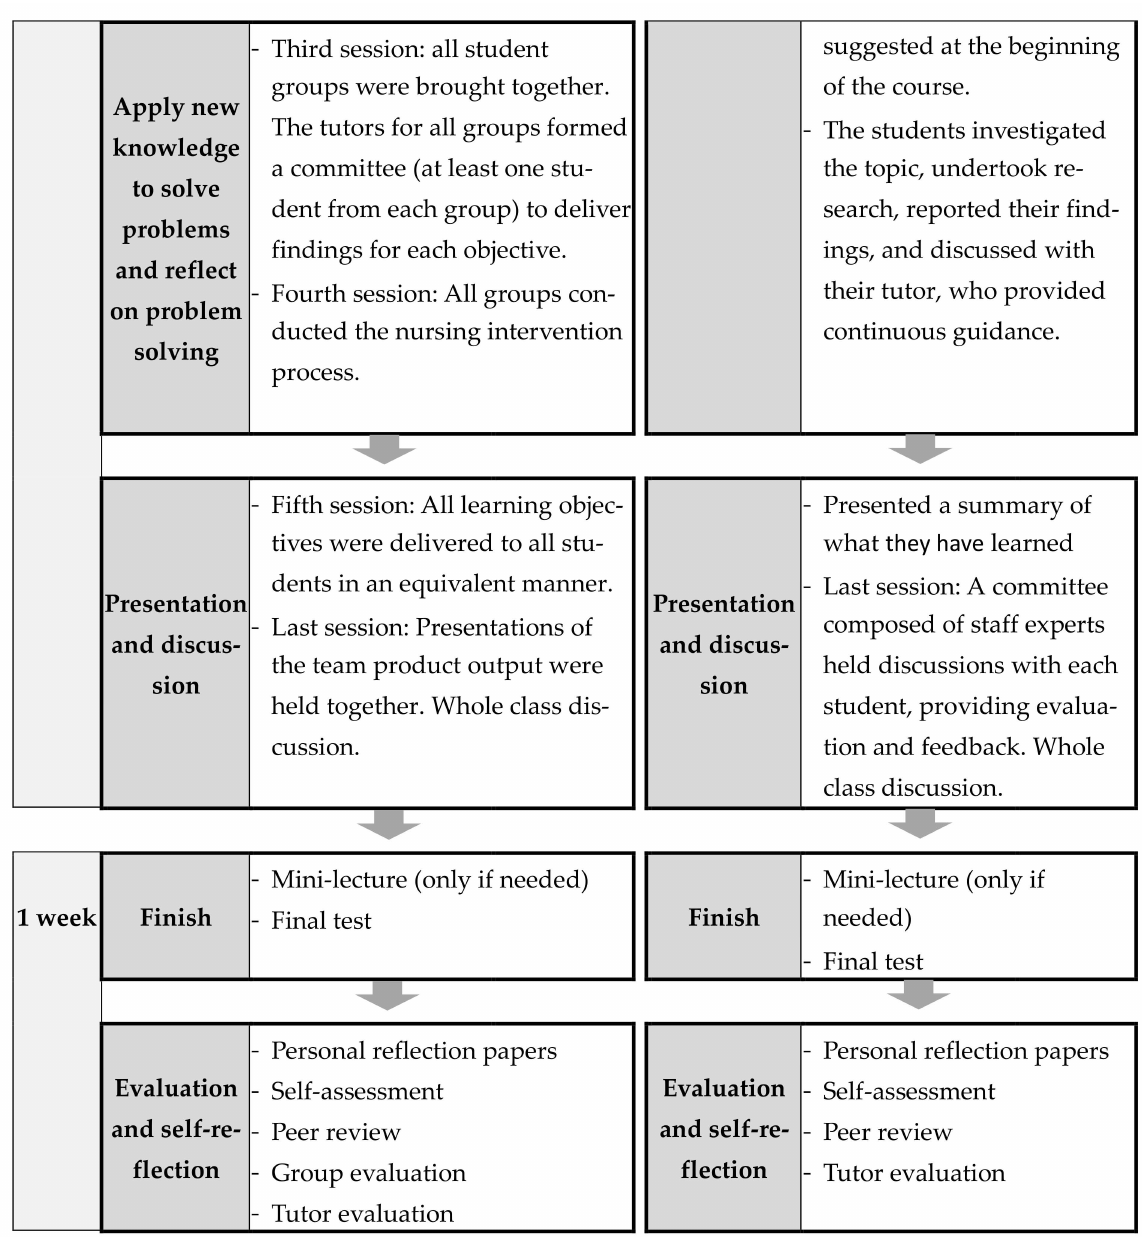
Figure 1. Education process of the PBL (Problem-based learning) and SDL (self-directed learning)